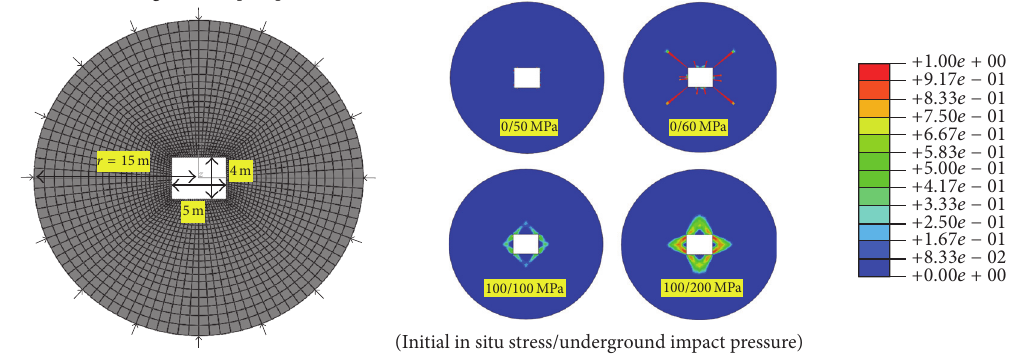
Figure 4: FEM model and failure mechanisms of surrounding rock for rectangular tunnel under different initial in situ stress.